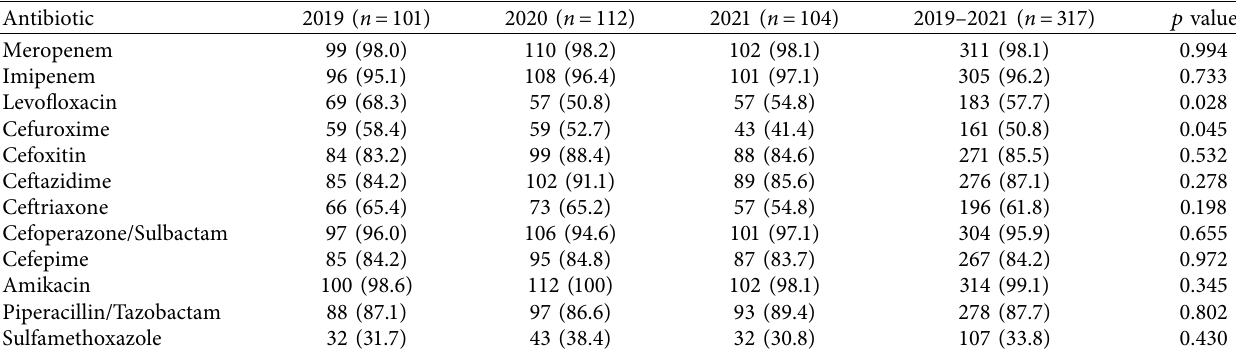
Table 3: Annual and total sensitivity profles based on antibiotic sensitivity trials of Proteus mirabilis isolates from urinary calculus patients during the 2019–2021 study period (%).